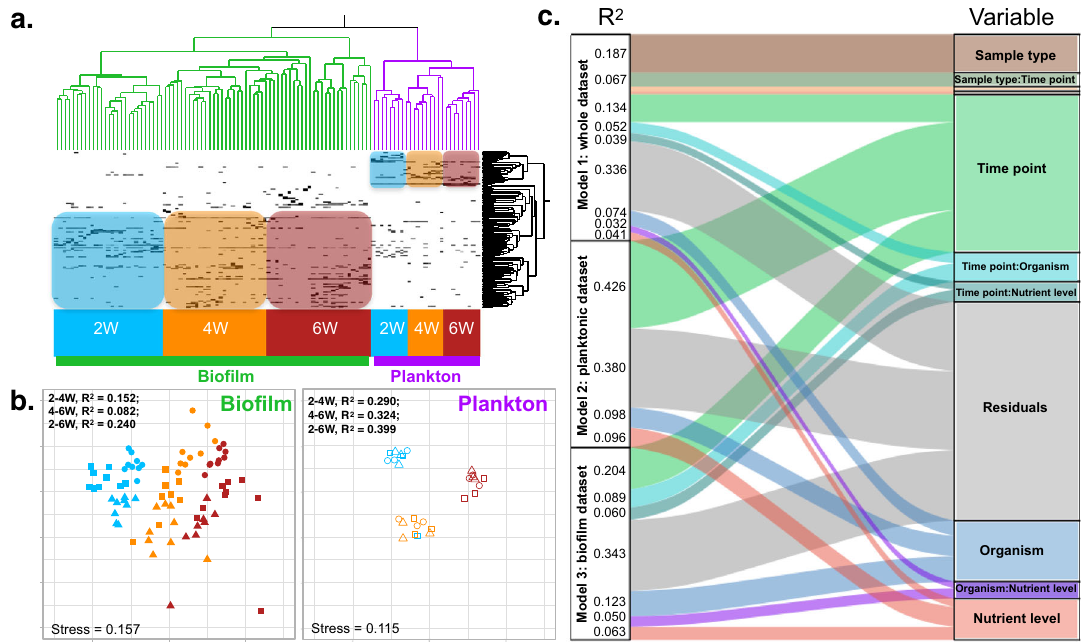
Fig. 2 Multivariate visualization and statistical differentiation of bio fi lm and planktonic bacterial communities. Hierarchical clustering (Ward ’ s minimum variance method) organized all OTUs in the study according to distributions of standardized ( z -scored) mean relative abundance across treatments. Throughout the 6-week experiment, bio fi lm communities were distinct from planktonic microbial communities while both clustered by time point ( a ). Bio fi lms displayed a successional trajectory not found in the planktonic community ( b ); data points are color coded by time point (2-weeks = blue, 4-weeks = gold, 6-weeks = red), and shaped by sample type and organism (open = planktonic, closed = bio fi lm; Triangle = algae, circles = coral, square = sand). Variance partitioning of three different PERMANOVA models ( c ) illustrate the relative in fl uence of sample type, time point, benthic organism, and nutrient enrichment on bacterial taxonomic structure of planktonic and bio fi lm communities. Model 1 combines both planktonic and bio fi lm communities and emphasizes that sample type is the strongest driver of microbial community composition. Time point has the next largest in fl uence on both planktonic (Model 2) and bio fi lm (Model 3) bacterial communities. Bio fi lm microbial communities are more strongly in fl uenced by benthic organism ( R 2 = 0.123) than nutrient treatment ( R 2 = 0.063), while these parameters are equally in fl uential in the planktonic community, explaining a much smaller variance (<1%). All tests and model terms shown are signi fi cant ( p <